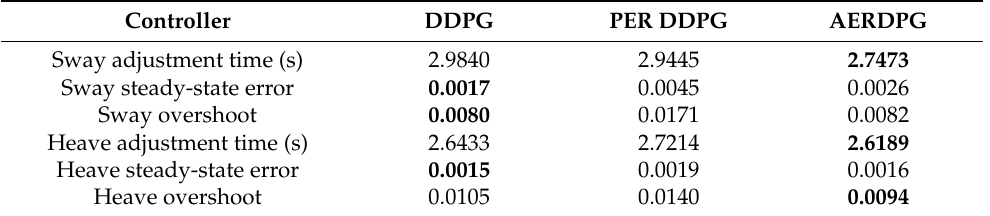
Table 3. The performance indicators of the two controllers (Bold represents the optimal value).